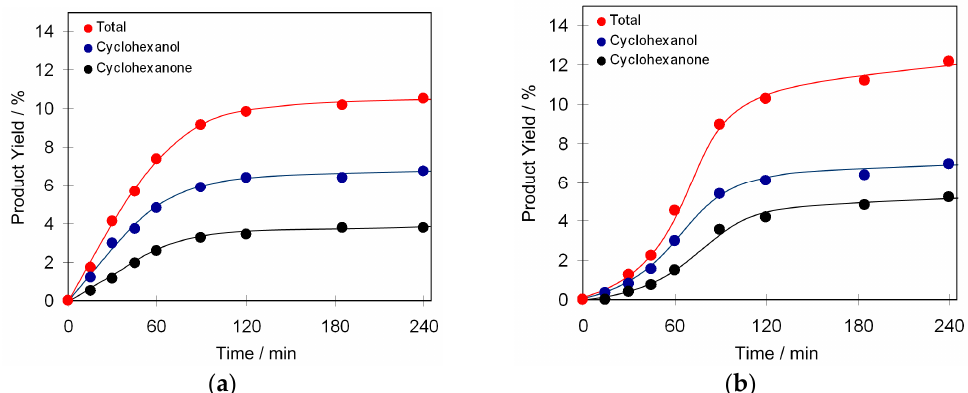
Figure 3. Kinetic curves of product accumulation in the cyclohexane oxidation by H 2 O 2 catalyzed by 1 ( a ) and 2 ( b ) in the presence of TFA promoter. Reaction conditions: Cu catalyst or catalyst precursor (5.0 ( 1 ) or 2.5 ( 2 ) µmol), TFA (0.05 mmol), C 6 H 12 (1.0 mmol), H 2 O 2 (5.0 mmol), CH 3 CN (up to 2.5 mL of the total volume), 50 °C.